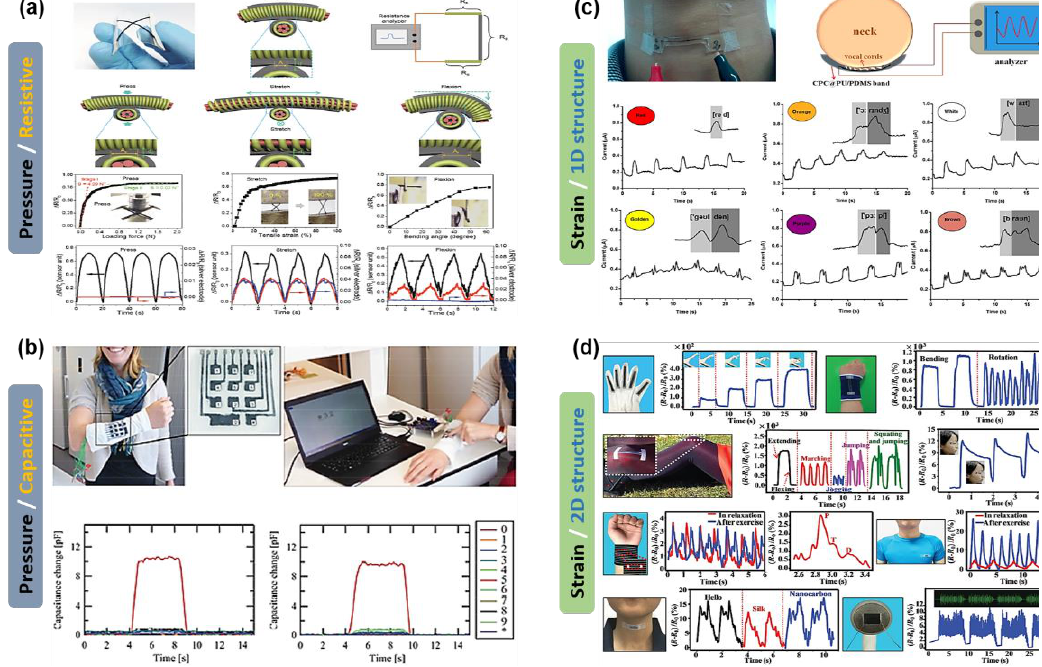
Figure 7. Textile-based wearable sensors for pressure and strain. ( a ) Highly stretchable sensor units / arrays with the intertwined composite fibers and piezoresistive rubber and mechanical–electric characteristics (reproduced with permission [137] copyright 2016, Wiley-VCH). ( b ) The stretchable keyboard on a knitted fabric using capacitance-type pressure sensor made of PDMS film and printed PEDOT:PSS electrodes and the changes in capacitance value against pressure (reproduced with permission [36] copyright 2016, Wiley-VCH). ( c ) Conductive polymer composites made of carbon black on a polyurethane (CPC@PU yarn) strain sensors attached on the neck and the current changes as the function of the pronouncing di ff erent words (reproduced with permission [141] copyright 2016 American Chemical Society). ( d ) Ultra-stretchable carbonized silk fiber-based strain sensors and various applications in human motions and sounds (reproduced with permission [143] copyright 2016, Wiley-VCH).